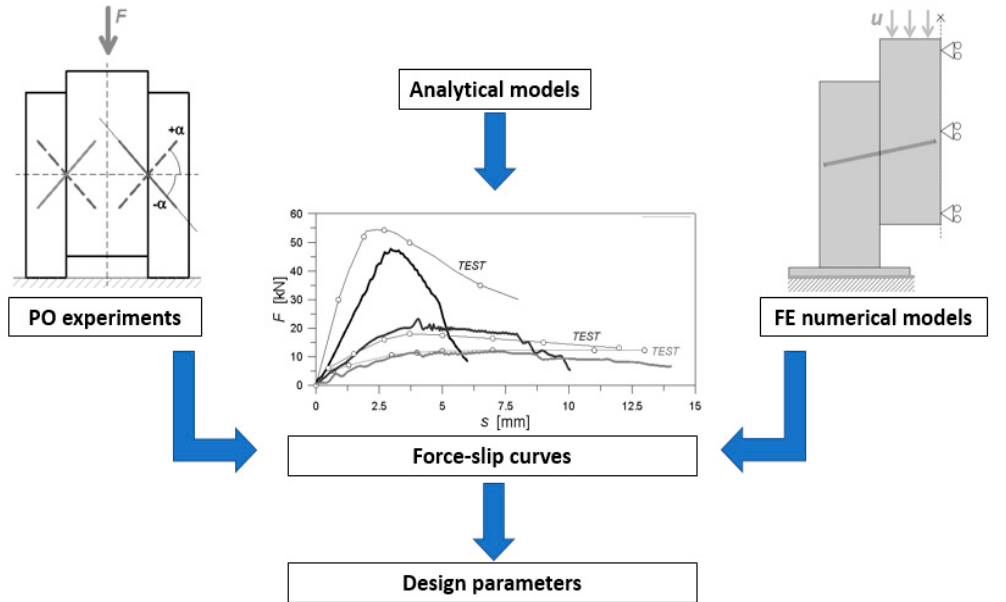
Figure 1. Available tools for the mechanical characterization and analysis of design parameters of timber-to-timber composite joints.